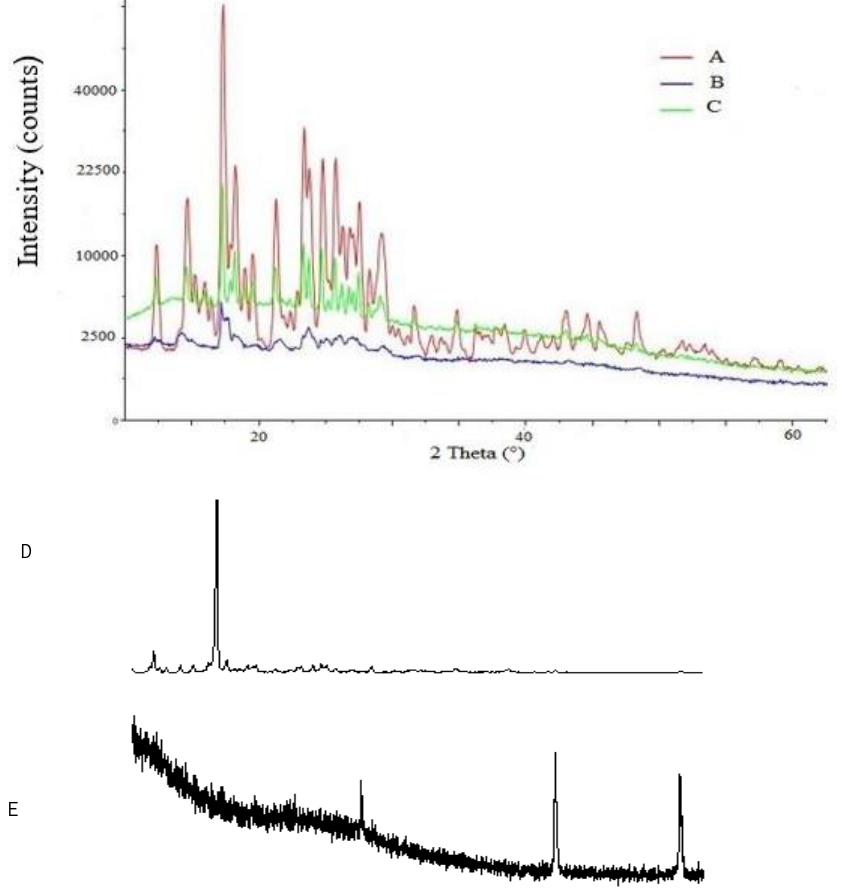
Figure 2. XRD analysis of ( A ) Free curcumin, ( B ) ALG-GA nanoparticles, ( C ) Cur/ALG-GANPs ( D ) Alginate, ( E ) Gum arabic.